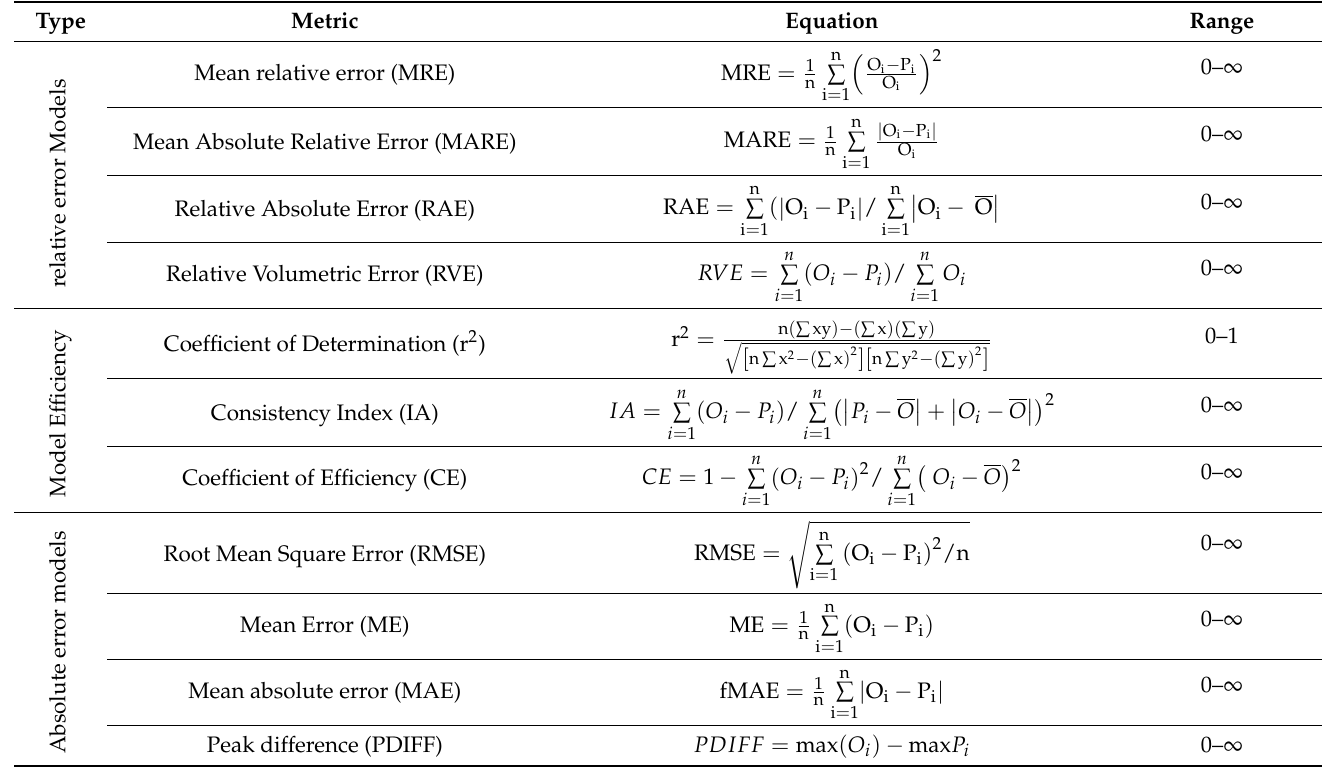
Table 2. Formulas and ranges of the validation